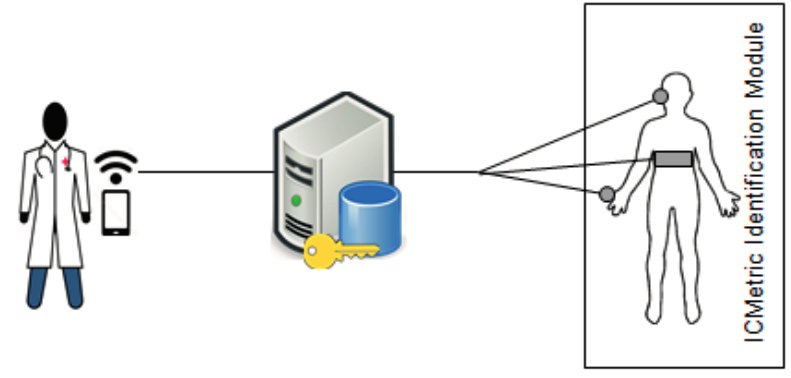
Figure 5. System model for an ICMetric based health monitoring